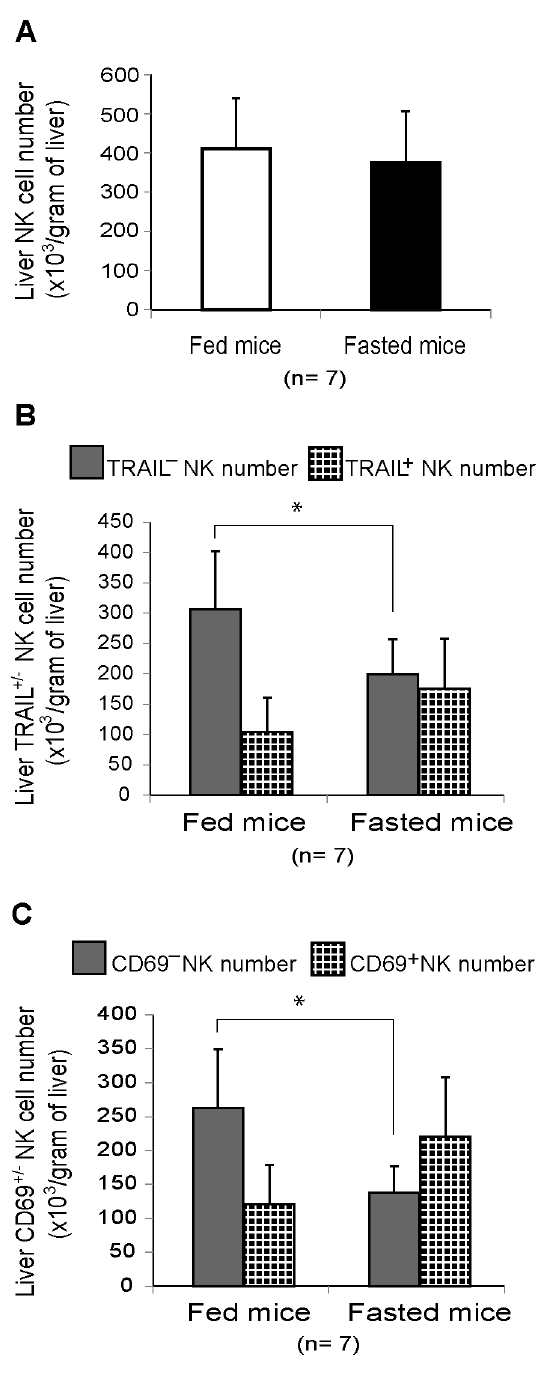
Figure 2. Distribution of TRAIL and CD69 expression in liver natural killer cells in response to starvation. Liver lymphocytes from fed mice and 3-day-fasted mice were stained with monoclonal antibodies and counted using flow cytometry. Numbers of (A) TCR b 2 NK1.1 + natural killer (NK) cells, (B) TRAIL + / 2 NK cells, and (C) CD69 + / 2 NK cells per gram of liver tissue are presented in bar graphs as mean plus standard deviation (n=7); * p , 0.05 as analyzed by the independent samples T